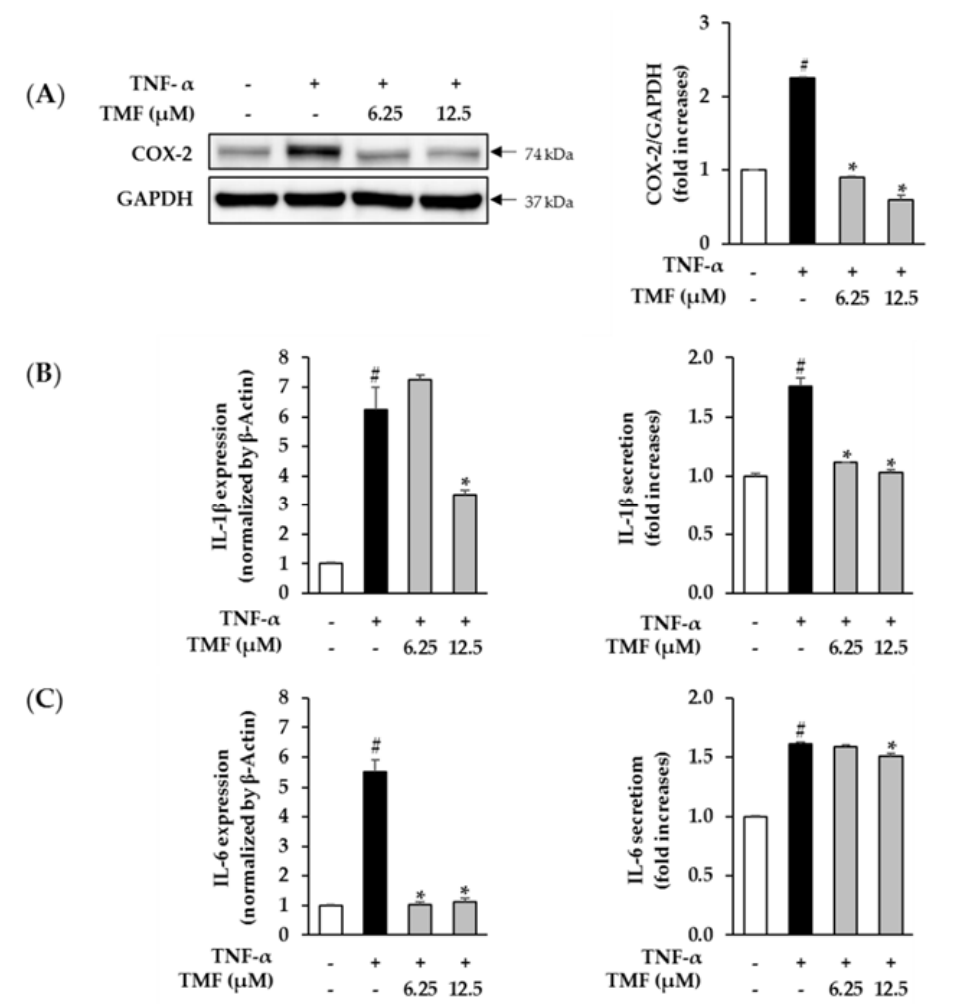
Figure 7. Effect of TMF on TNF-α-induced COX-2, IL-1β, and IL-6 expression in HDFs. ( A ) Expression of the pro-inflammatory mediator, COX-2, in TNF-α-stimulated HDFs was detected using western blotting. The data are described as mean ± SEM ( n = 3). # p < 0.05 compared to non–treated group and * p < 0.05 compared to TNF-α–